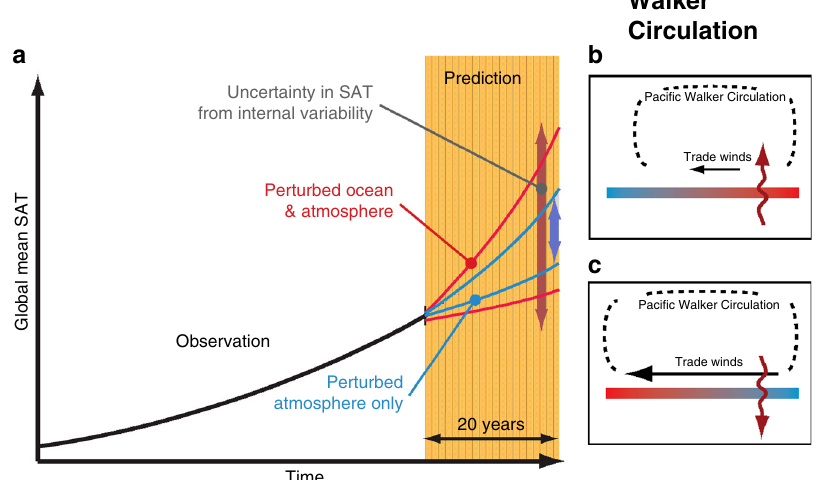
Fig. 6 Schematic of the range in simulated global mean temperature trajectories due to tropical Paci fi c climate variability. a The black curve refers to the observed GMT warming in response to increased radiative forcing. Blue (red) curves in a denote the projected GMT when the observed oceanic state is used (not-used) to initialize the subsequent climate projections. Corresponding red and blue arrows in a indicate the level of uncertainty for each case. Shown in b – c are the scenarios wherein accelerated ( b ) and reduced ( c ) GMT warming is often associated with anomalous Paci fi c trade winds (and thus Walker Circulation strength) and corresponding anomalous heat fl uxes between the ocean and